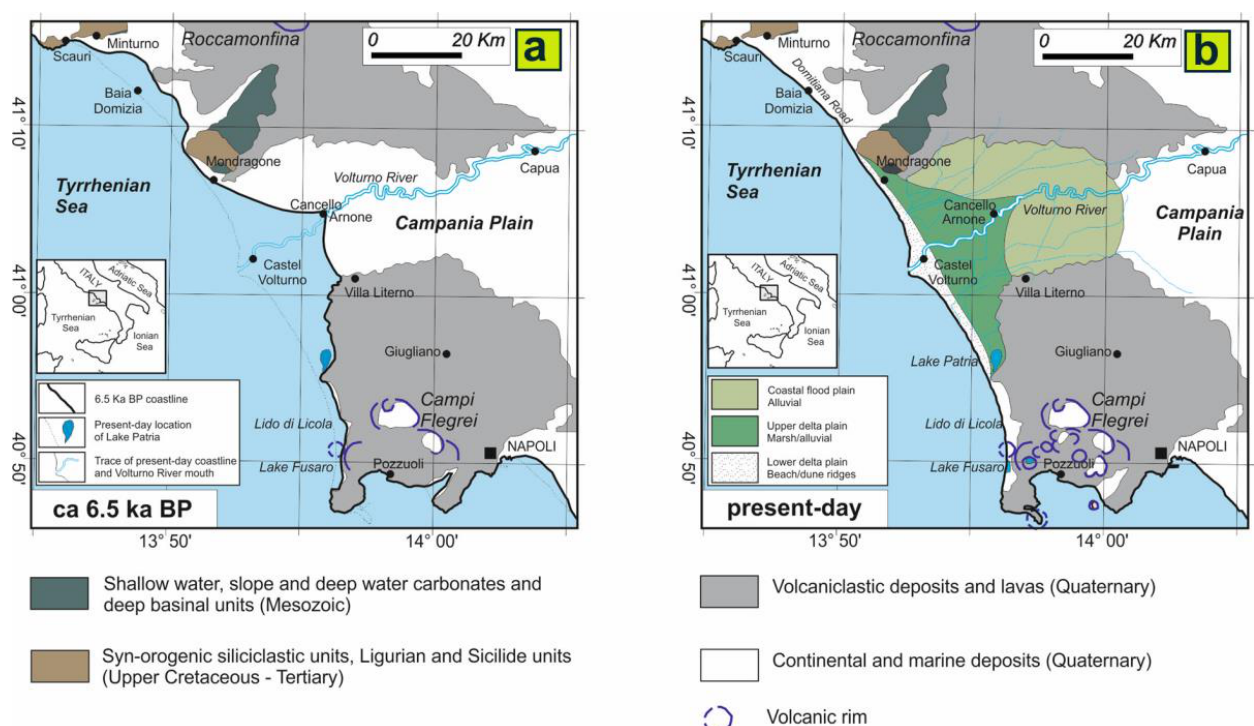
Figure 2. Sketch map of the Late Holocene to present-day geomorphological evolution of the Volturno River delta plain: ( a ) approximate location of the coastline 6.5 ka BP, inferred from facies analysis based on Sacchi et al. [32]; ( b ) actual location of the coastline.